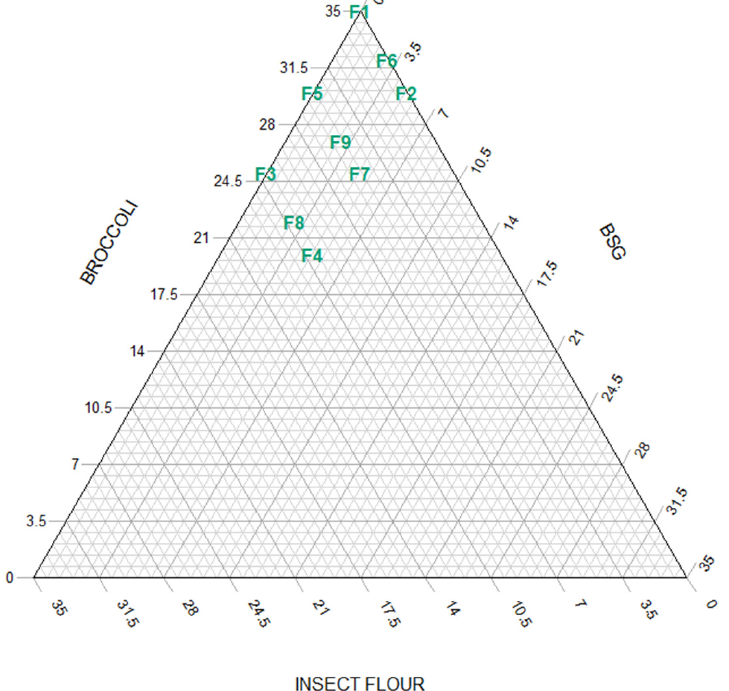
Figure 1. Simplex design plot of ingredient proportions for sausages with replacements adding up to 35%. The samples, labelled from F1 to F9, contain different percentages of broccoli, upcycled brewer’s spent grain and insect flour (BR, BSG, IF): F1 (35, 0, 0), F2 (30, 5, 0), F3 (25, 0, 1), F4 (20, 5, 10), F5 (30, 0, 5), F6 (32, 3, 0), F7 (25, 5, 5), F8 (22, 3, 10) and F9 (27, 3, 5). Different sausage formulations were labelled with F1 to F9 (Figure 2). All 9 combi- nations contained 400 g of frozen turkey meat, 97 g of canned fried onion, 91.5 g of cold (CMC), 1.8 g of parsley, 0.9 g of sweet paprika and 0.9 g of black pepper. The